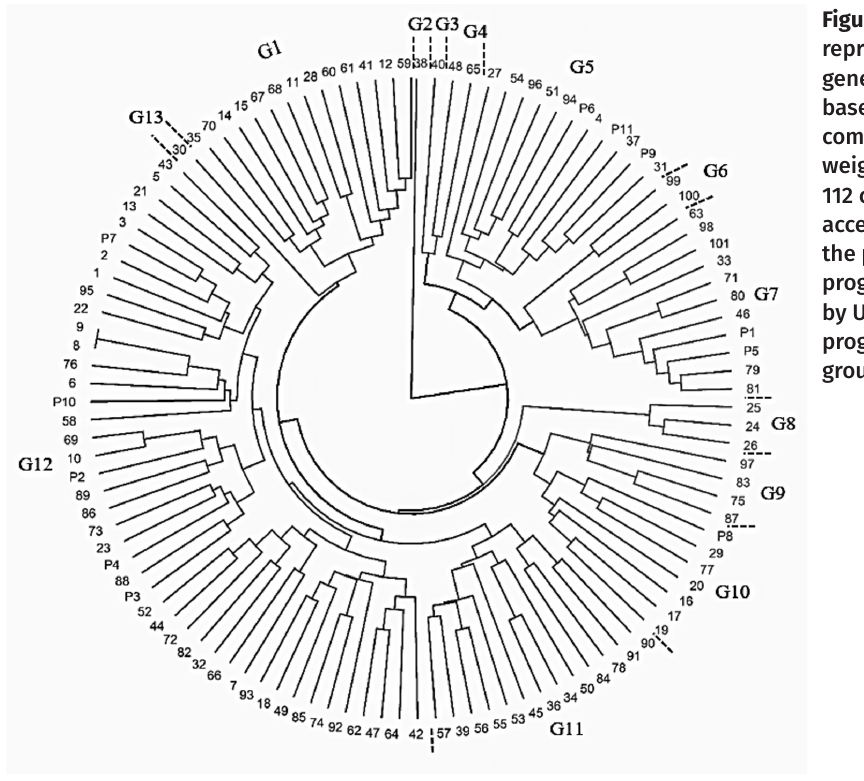
Figure 4. Dendrogram representative of genetic dissimilarity based on the complement of weighted index in the 112 conilon coffee accessions, considering the parents and their progenies, obtained by UPGMA using the program R, forming 13